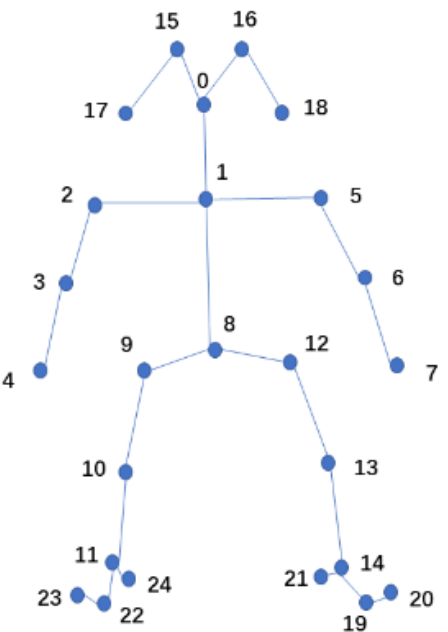
Figure 1. Configuration of 25 body joints in our dataset. The labels of the joints are: 0 = Nose, 1 = Neck, 2 = RShoulder, 3 = RElbow, 4 = RWrist, 5 = LShoulder, 6 = LElbow, 7 = LWrist, 8 = MidHip, 9 = RHip, 10 = RKnee, 11 = RAnkle, 12 = LHip, 13 = LKnee, 14 = LAnkle, 15 = REye, 16 = LEye, 17 = REar, 18 = LEar, 19 = LBigToe, 20 = LSmallToe, 21 = LHeel, 22 = RBigToe, 23 = RSmallToe, 24 = RHeel. R = right, L = left.